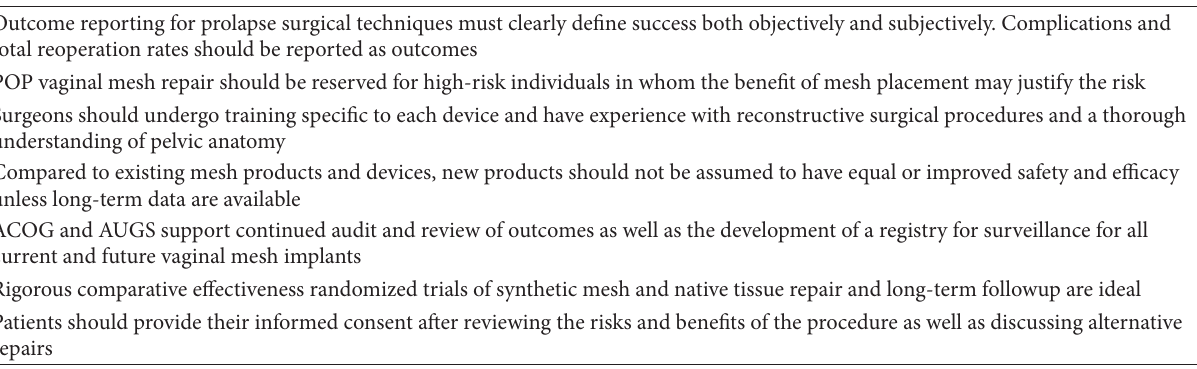
Table 3: Recommendations for the safe and effective use of vaginal mesh for repair of